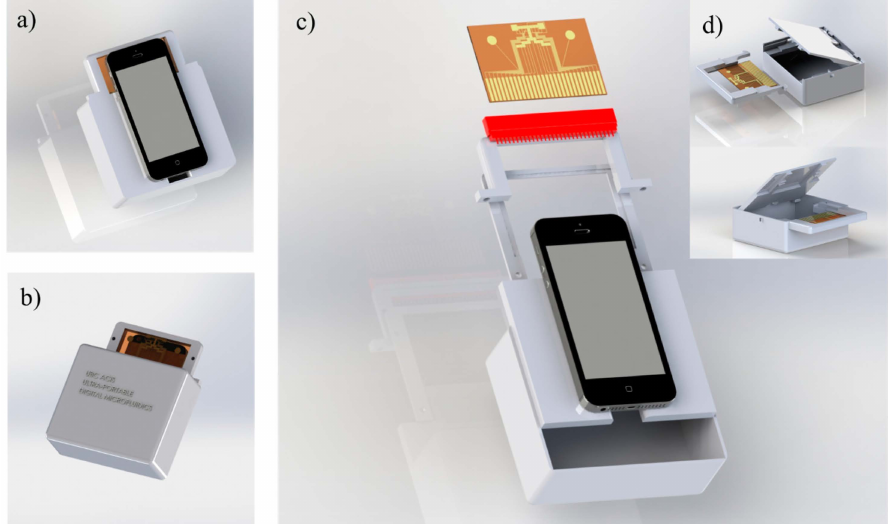
Figure 7. A 3D CAD model (SolidWorks, Dassault Systemes, Vélizy-Villacoublay, France) for the modular DMF platform. ( a ) Front view showing how the phone is attached on top of the device, ( b ) back view, ( c ) exploded view showing the parts required for inserting the chip inside the device, and ( d ) shows how the DMF chip can be replaced and installed easily to the